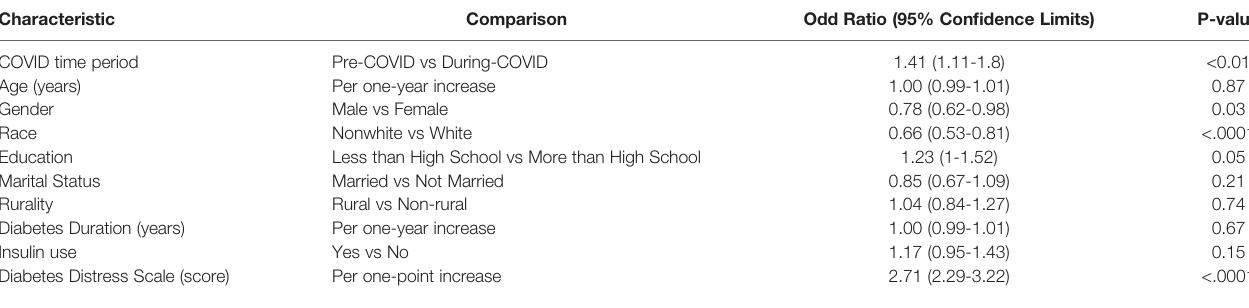
TABLE 2 | Association of COVID time period on self-reported poor health among survey participants with type 2 diabetes covered by Alabama Medicaid (N = 1,822). Characteristic